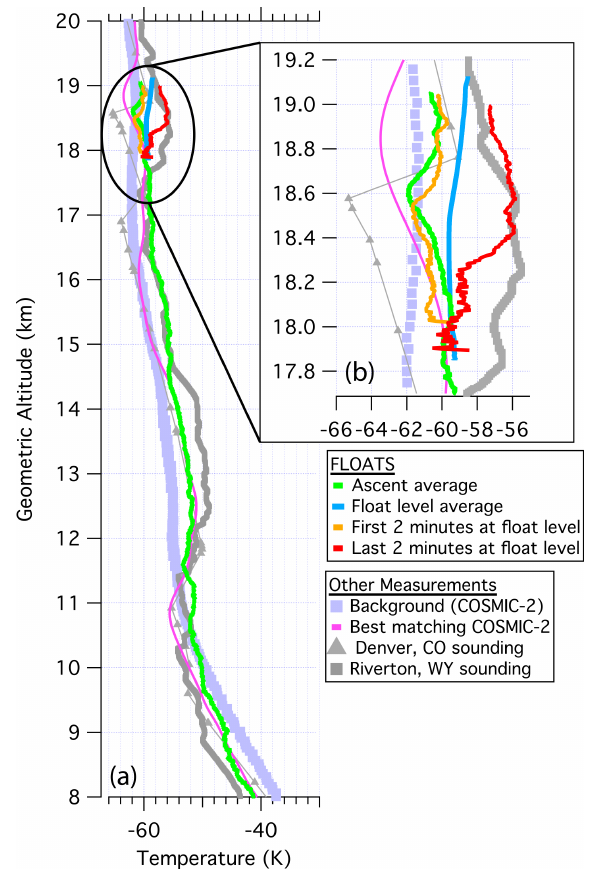
Figure 6. (a) Temperature profiles in ◦ C for the background tem- perature derived from COSMIC-2 temperature; radio sounding tem- peratures from Denver, Colorado (Station 72469); and Riverton, Wyoming (72672), for 22 January 2021 12:00UTC and FLOATS DTS. The FLOATS 5m ascent profile (green), float-level average (blue), and average temperature profiles from the beginning (or- ange) and end (red) of float altitude are displayed. (b) Zoomed-in section of panel (a) from 17.7 to 19.2km